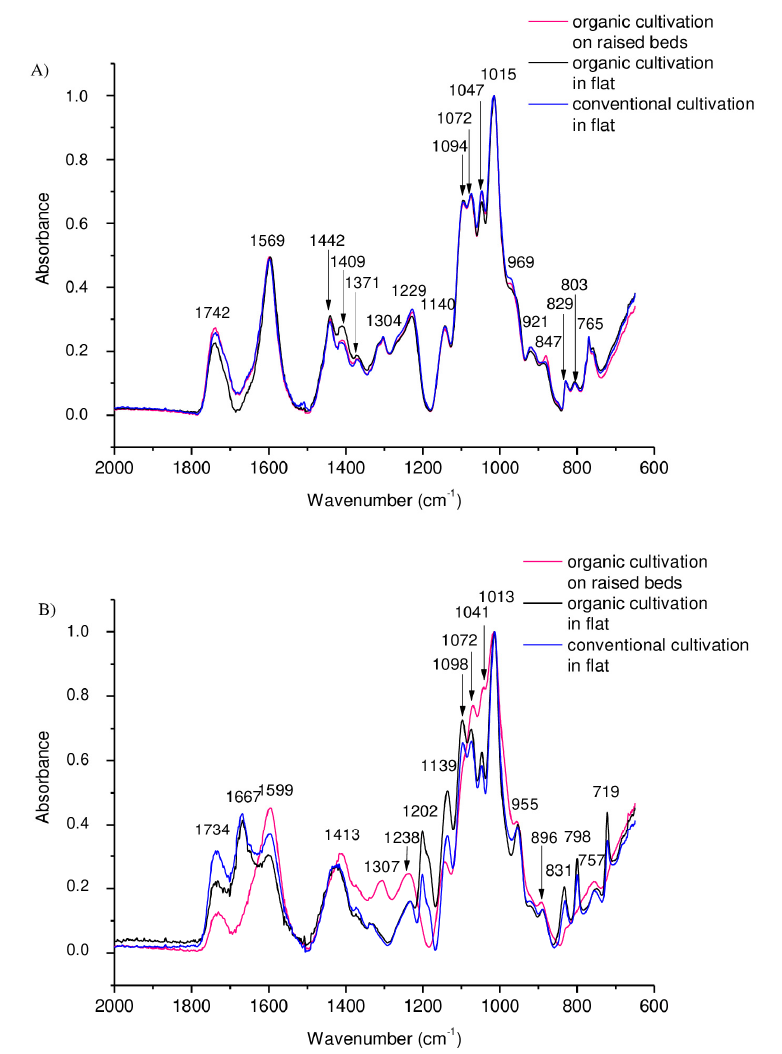
Figure 3. FT-IR spectrum of pectin after extraction with ammonium oxalate from strawberries cv. Honeoye cultivated in three different ways on ( A ) the day of harvest (T0) and ( B ) the twelfth day of storage (T12).